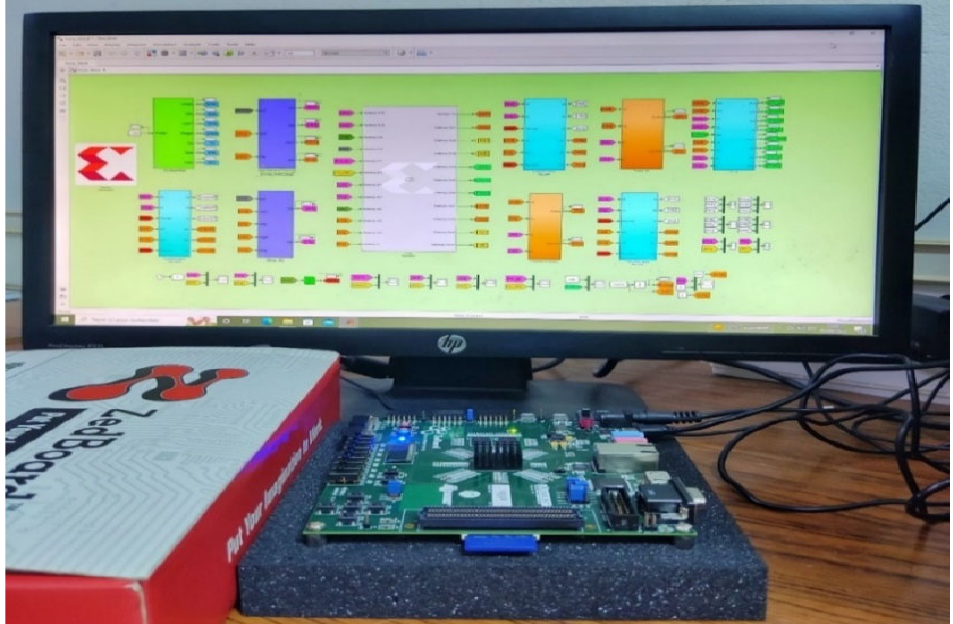
Figure 36. Hardware co-simulation for VCS-FGS-PID controllers.